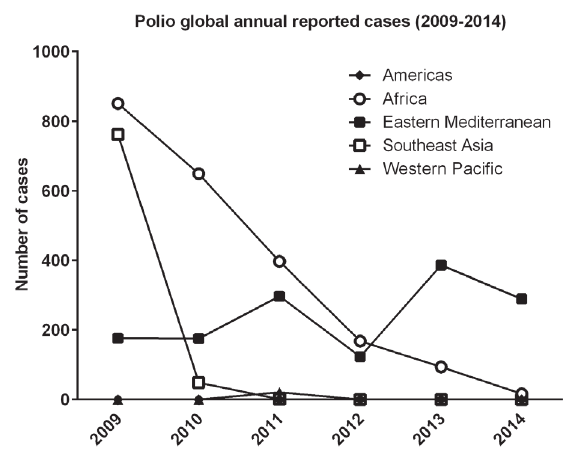
Figure 3 - Polio global annual reported cases (2009-2014). Countries are distributed by regions; data summarized from WHO (2014); http://apps.who.int/immunization_ monitoring/globalsummary;